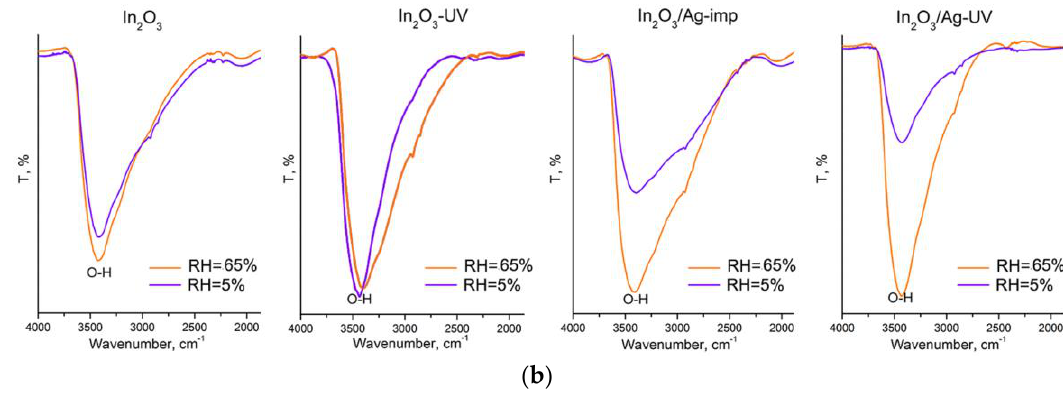
Figure 8. ( a ) FTIR spectra of In 2 O 3 and In 2 O 3 /Ag nanocomposites normalized to the intensity In–O oscillations. ( b ) FTIR spectra of In 2 O 3 and In 2 O 3 /Ag nanocomposites pretreated under different relative humidity RH = 65% and RH = 5%.